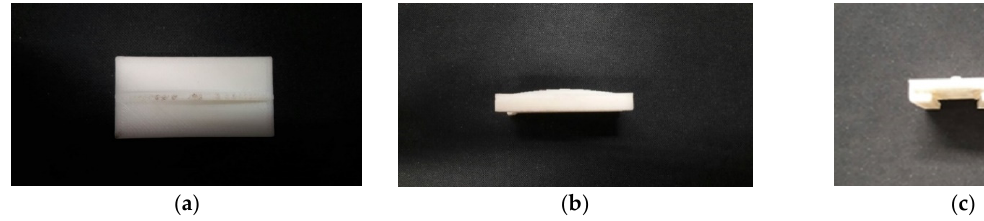
Figure 10. PZT protector: ( a ) top view, ( b ) side view, ( c ) front view.